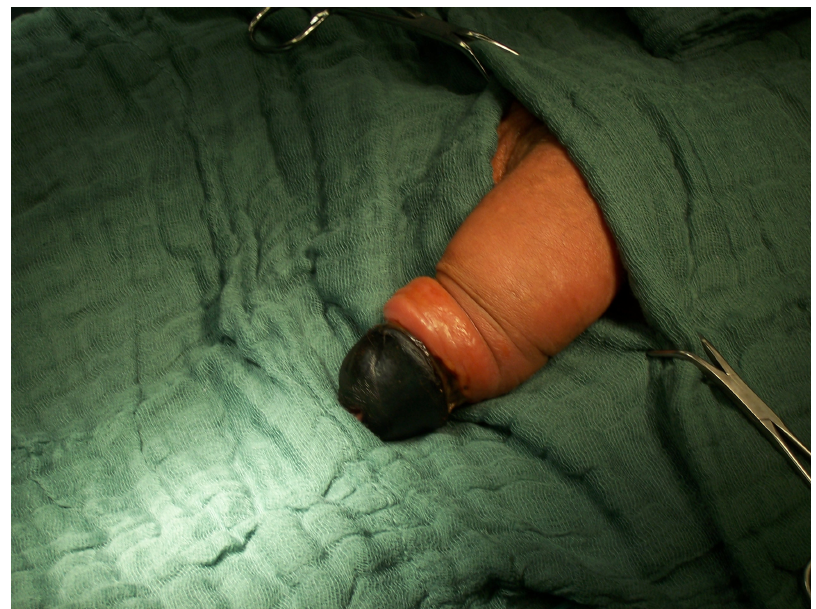
FIGURE 1. Preoperative view exhibiting dry gangrene of the glans with involvement of the distal